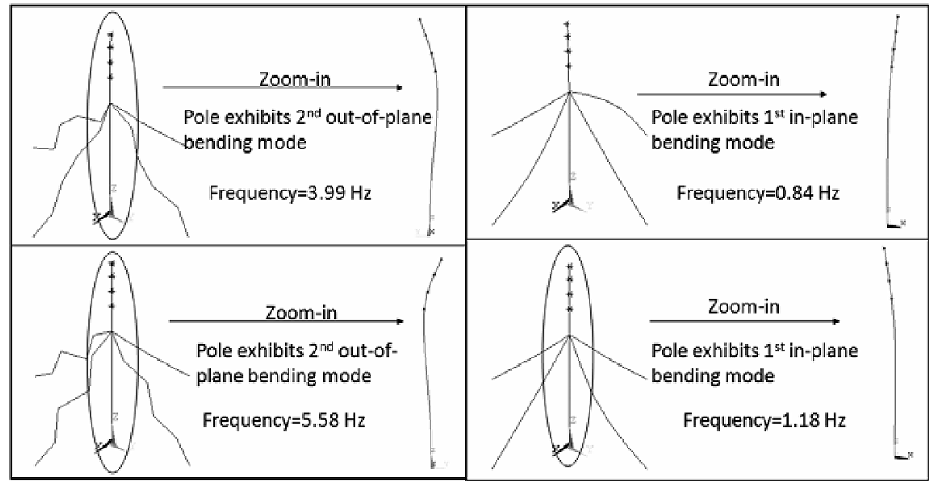
Fig. 8. Typical guy wire dominating modes for the simplified guyed steel